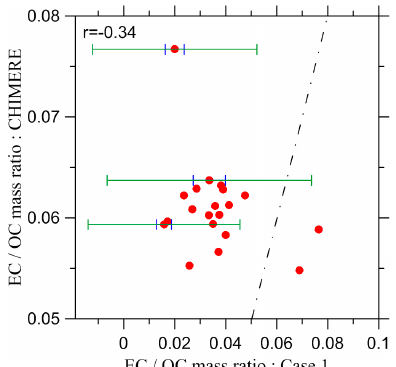
Figure 6. The relationship between the EC/OC mass ratios derived from the AERONET measurements and predicted with the CHIMERE chemistry transport model (CTM) (based on the emission factors used in the Global Fire Emissions Database 4 (GFED4) emission inventory). The error bars shown by green lines depict the 90% confidence intervals that were evaluated by taking into account both the uncertainty of the approximations and the probable error (of 0.03) of individual SSA observations, while the 90% confidence intervals depicted by blue brackets include only the uncertainty of the assumed relationship between SSA and the EC/OC ratio. The dot-dashed line depicts the 1:1 ratio.